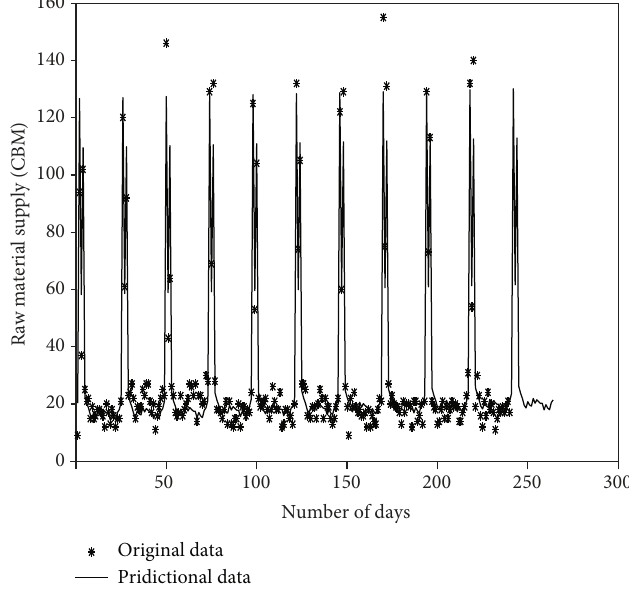
Figure 2: Comparison of original data and predictional